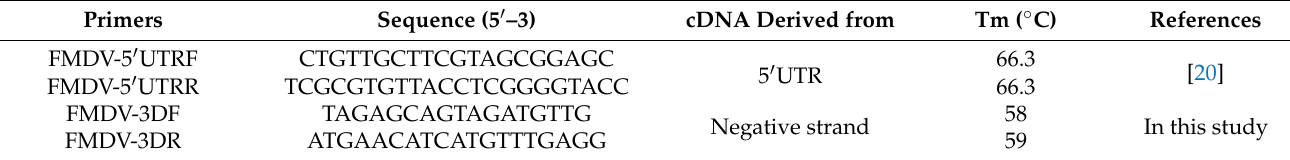
Table 1. Primers used in this study for amplification of FMDV